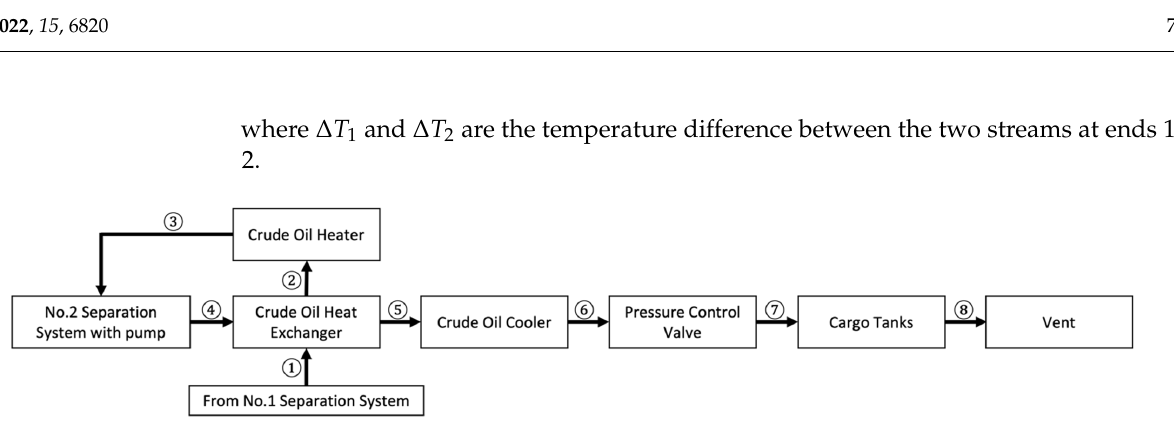
Figure 6. Schematic diagram of topside modules. Table 3. Heat and mass balance.